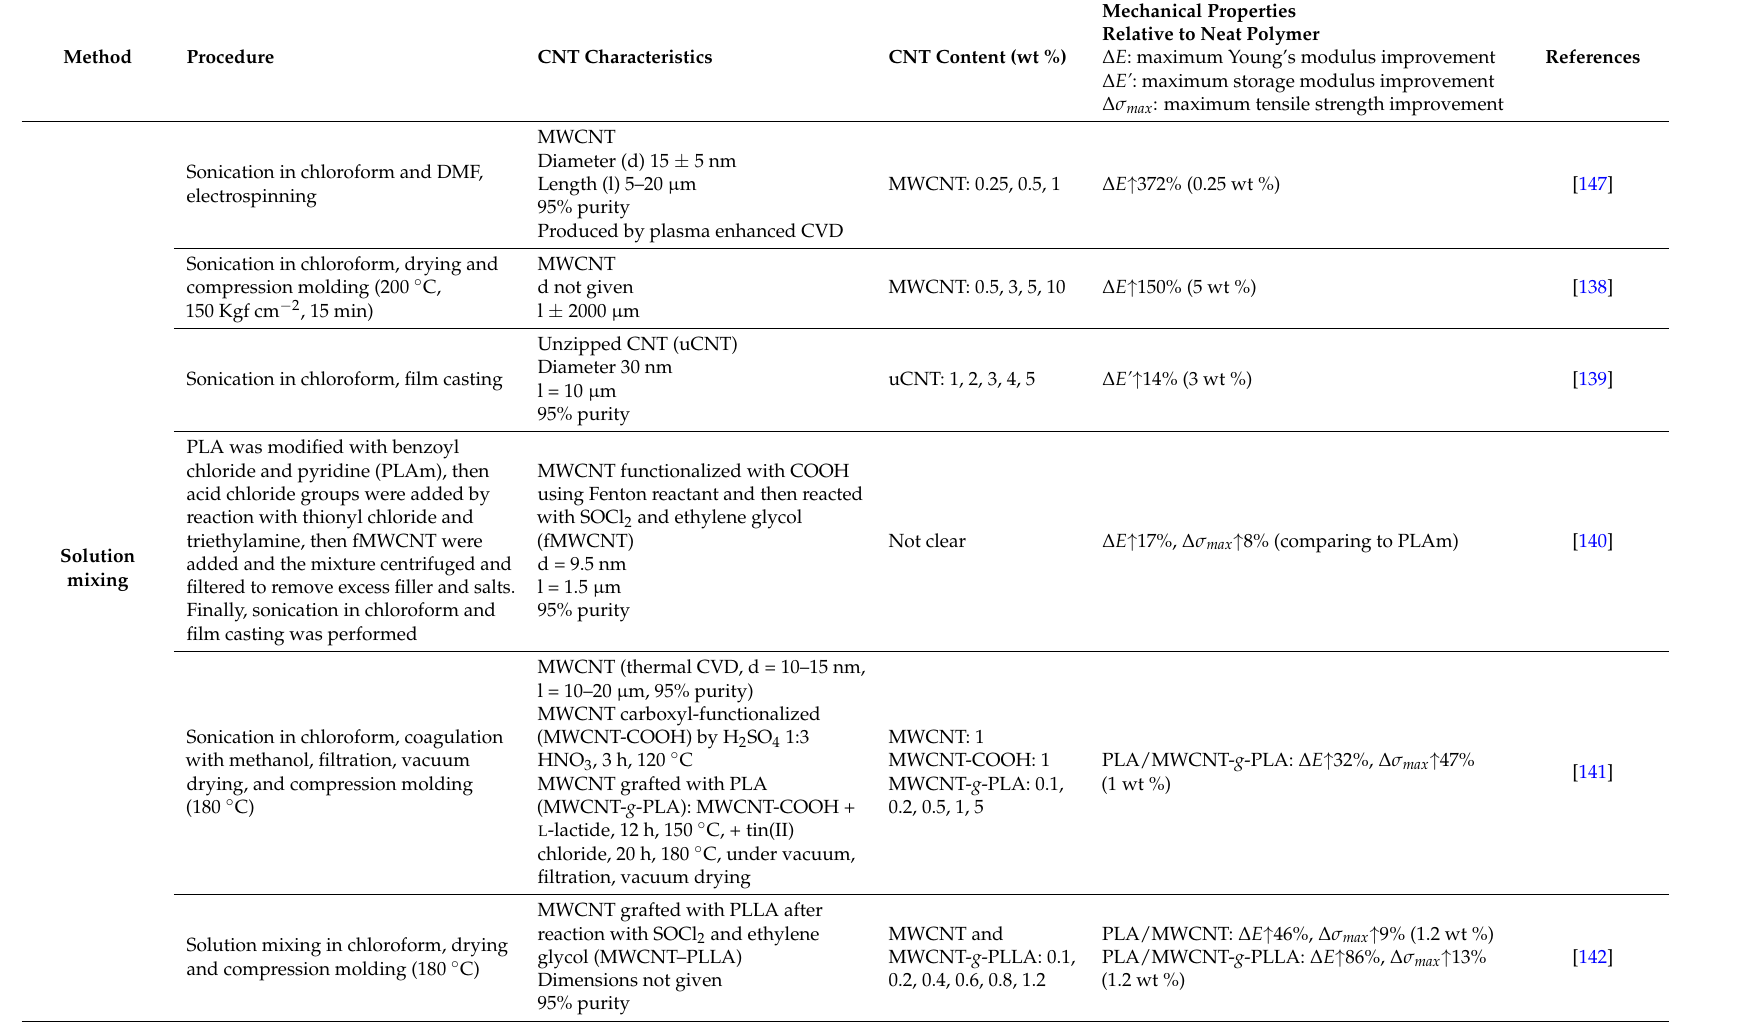
Table 1. Mechanical properties of PLA/CBN composites in comparison with non-modified PLA. Production methods and CBN